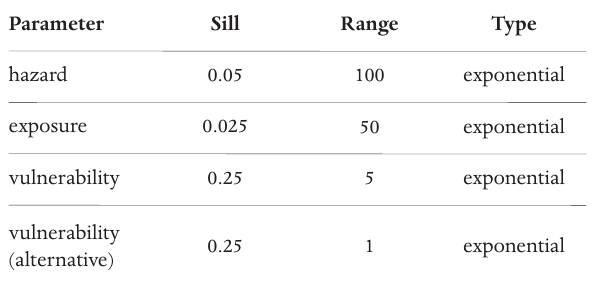
Table 4. Comparative results of estimations based on different sam- pling designs. SRS=Simple Random Sampling, PPS=Probability Proportional to Size, SS=Sample Size. 100 samples without re- placement, each replicated 1000 times and averaged.